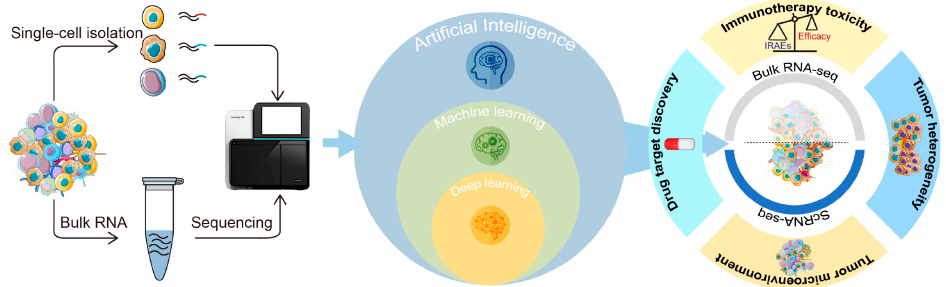
Figure 2. The applications of AI-assisted transcriptomics in cancer research. Transcriptomic tech- nologies have become powerful tools to profile the cancer transcriptome at both bulk and single- cell levels. Currently, AI approaches have been pivotal in exploiting the big data generated by tran- scriptomic analysis. In particular, the application of machine learning and deep learning in the field of transcriptomic research is rapidly growing. AI-assisted transcriptomics has been frequently uti- lized to investigate tumor heterogeneity, the tumor microenvironment, novel target discovery, and immunotherapy